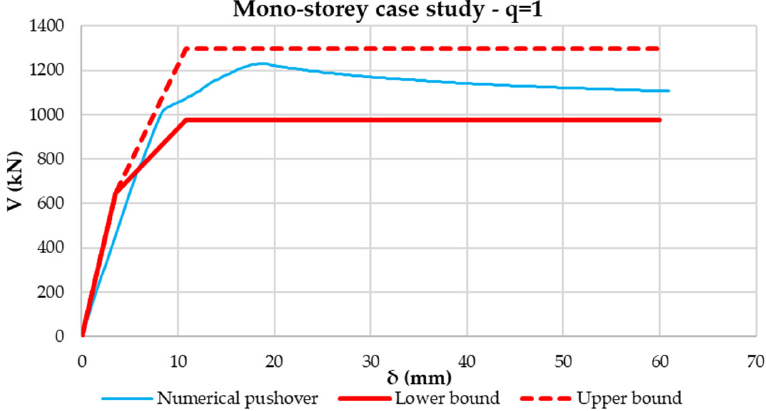
Figure 20. Comparison between numerical pushover curve and analytical spindle for the mono-storey building case study with structure factor equal to 1.